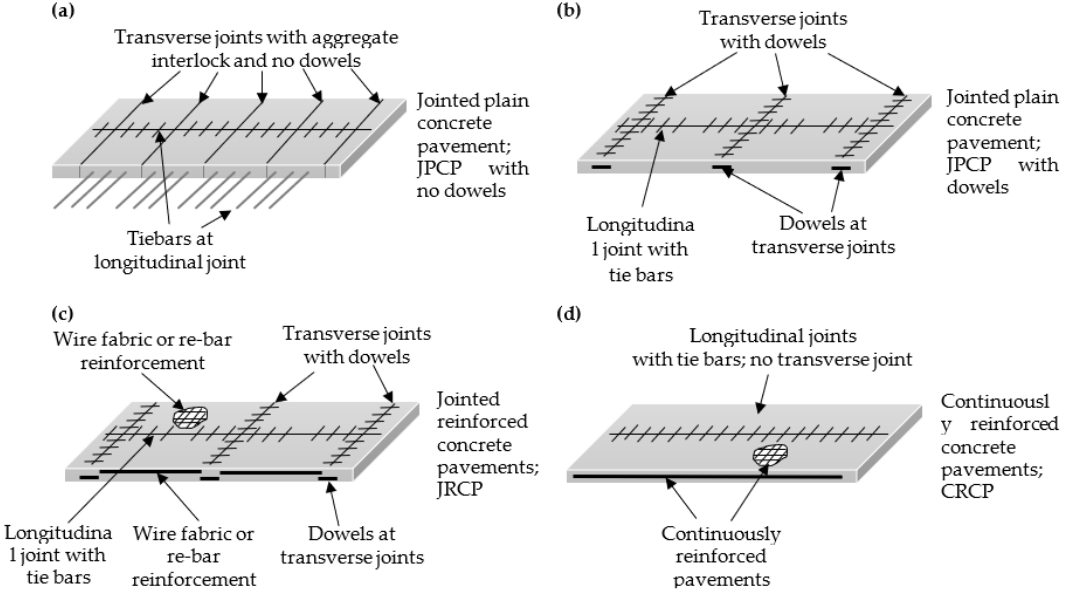
Figure 7. Jointed plain concrete pavement (JPCP) with tiebars and ( a ) no dowels and ( b ) with dowels, ( c ) jointed reinforced concrete pavements with tiebars and dowels, ( d ) continuously reinforced concrete pavements (CRCP). The figure was adapted from [41].